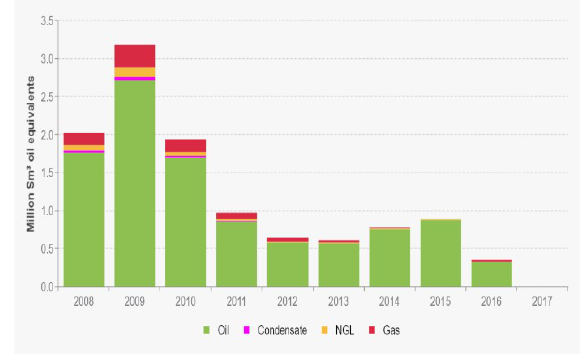
Figure 1. Pictorial representation of production data from the field (Norwegian petroleum directorate,2015). The X-axis shows the years and the y-axis shows the equivalents of hydrocarbon produced in millions standard cubic meter .